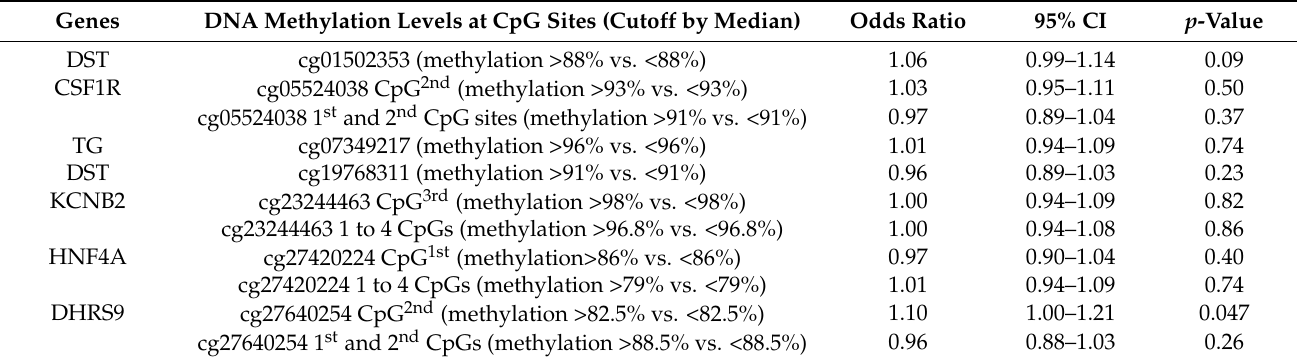
Table 4. Adjusted odds ratios (95% CI) between cord DNA methylation levels (cutoff 50 th percentile) at 8 CpG sites and low birth weight (<2500 g) calculated in an adjusted logistic regression